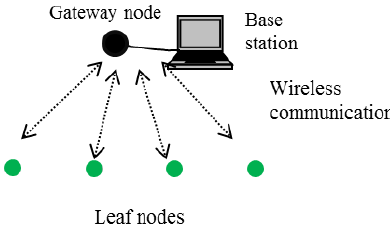
Figure 1. Illustration of a wireless network.